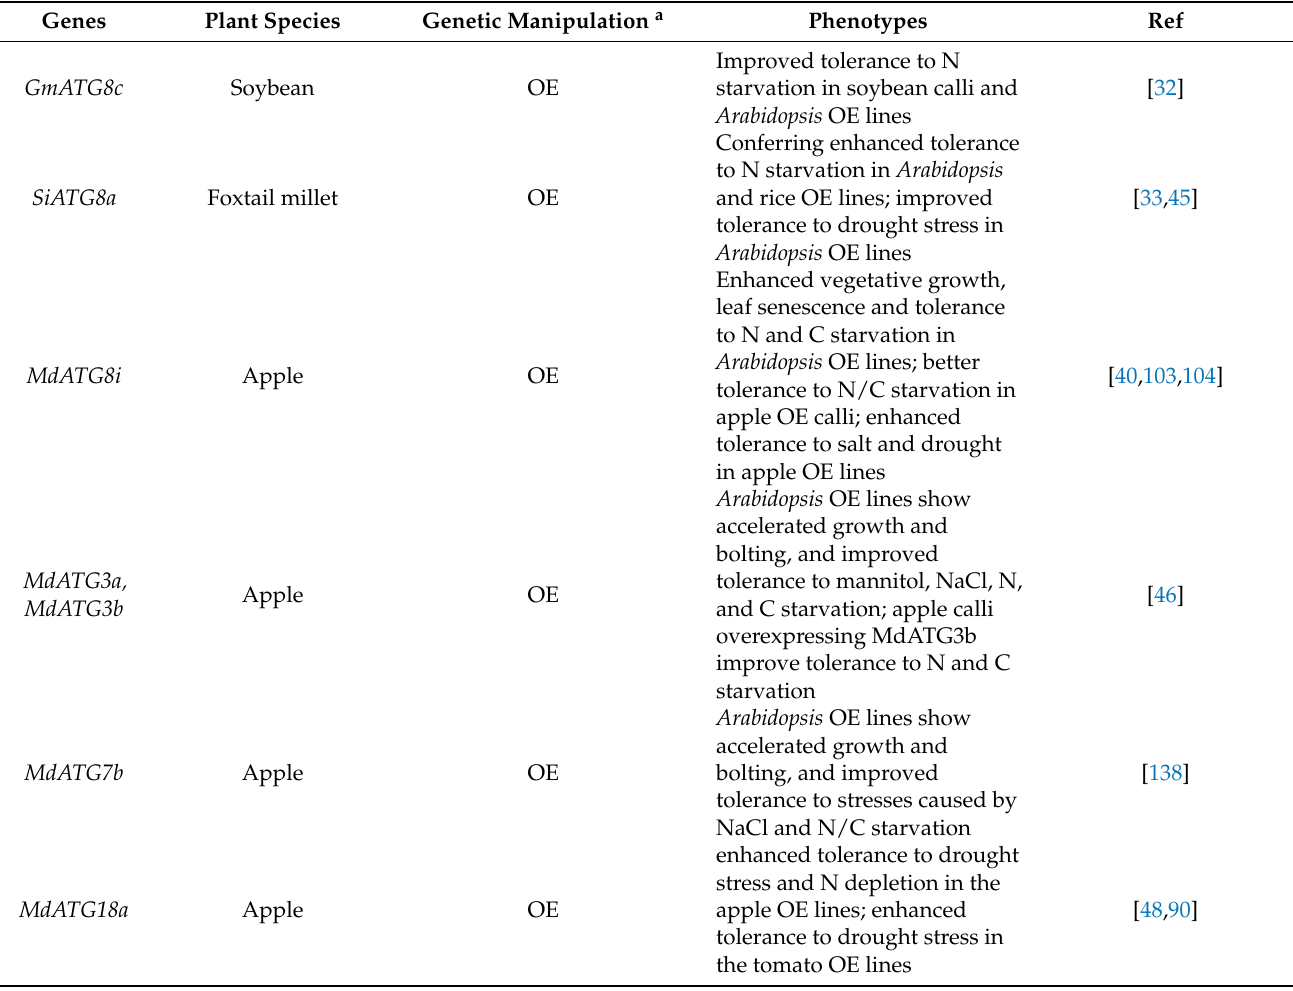
Table 1. Potential targets for autophagy manipulation to improve the agronomic